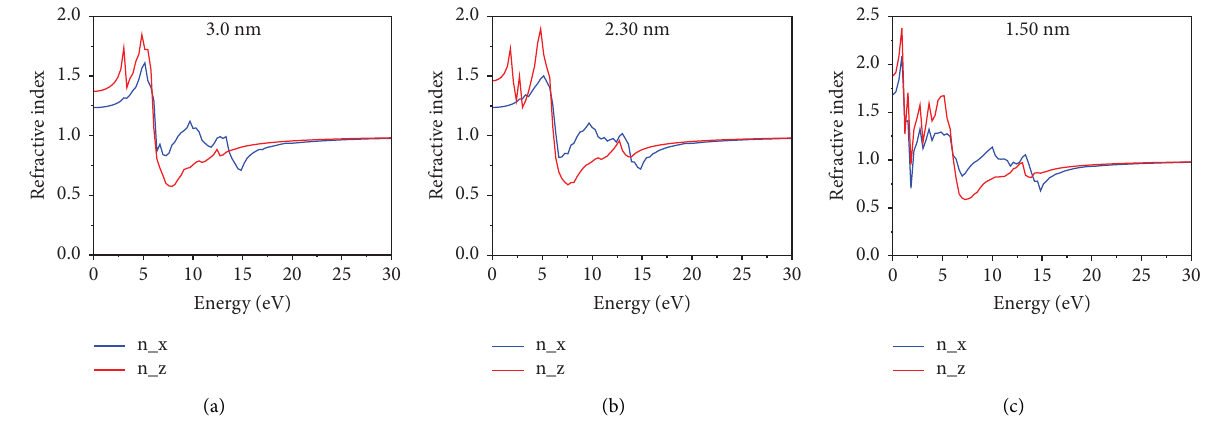
Figure 11: Refractive indices for armchair CBNNT under diferent IWDs.